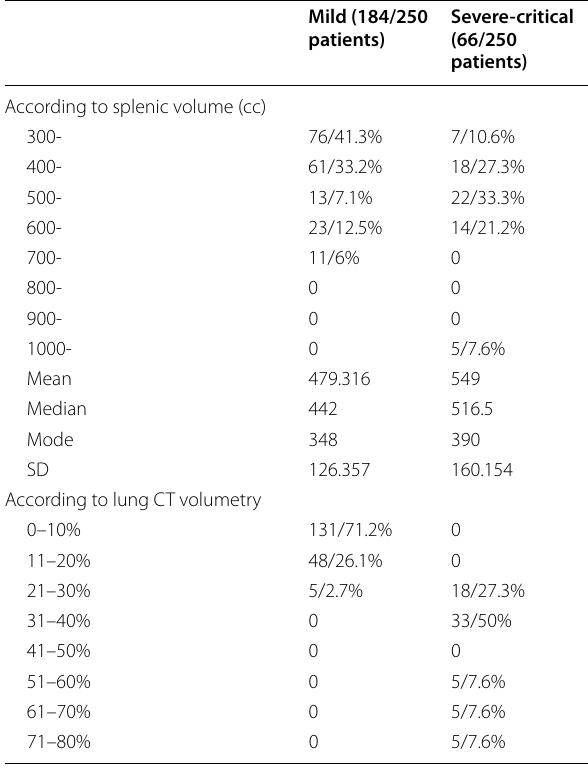
Table 3 Distribution of patients with splenomegaly according to splenic volume (cc) and lung CT volumetry among mild